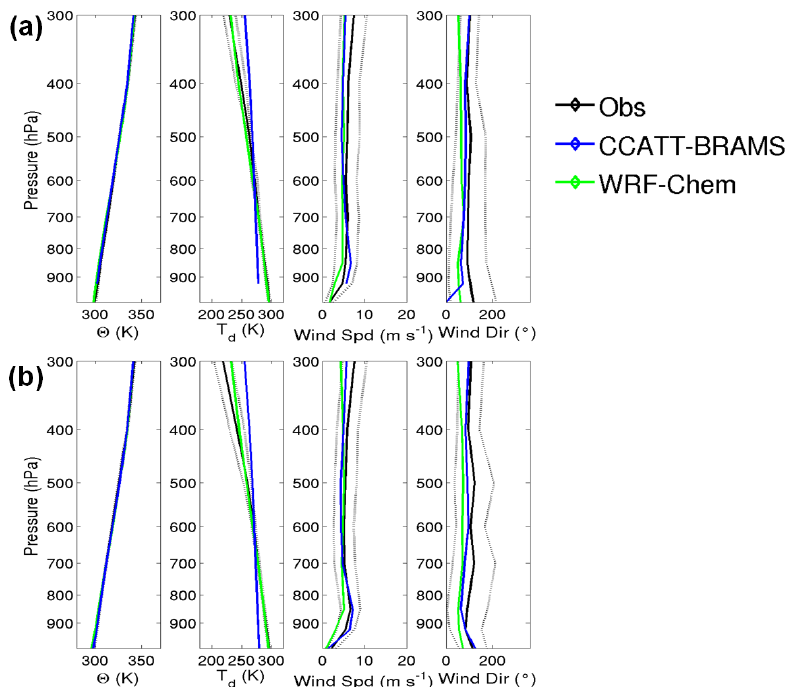
Figure 9. Mean vertical profiles at Manaus from radiosoundings (black, gray line denotes 1 standard deviation), CCATT-BRAMS (blue) and WRF-Chem (green) for April–May 2009 at (a) 0 and (b) 12:00UTC.